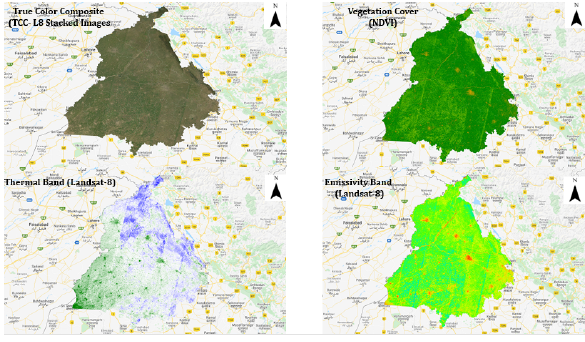
Figure 4: Results (Stacked Landsat -8 TCC, Vegetation Cover (NDVI), Thermal